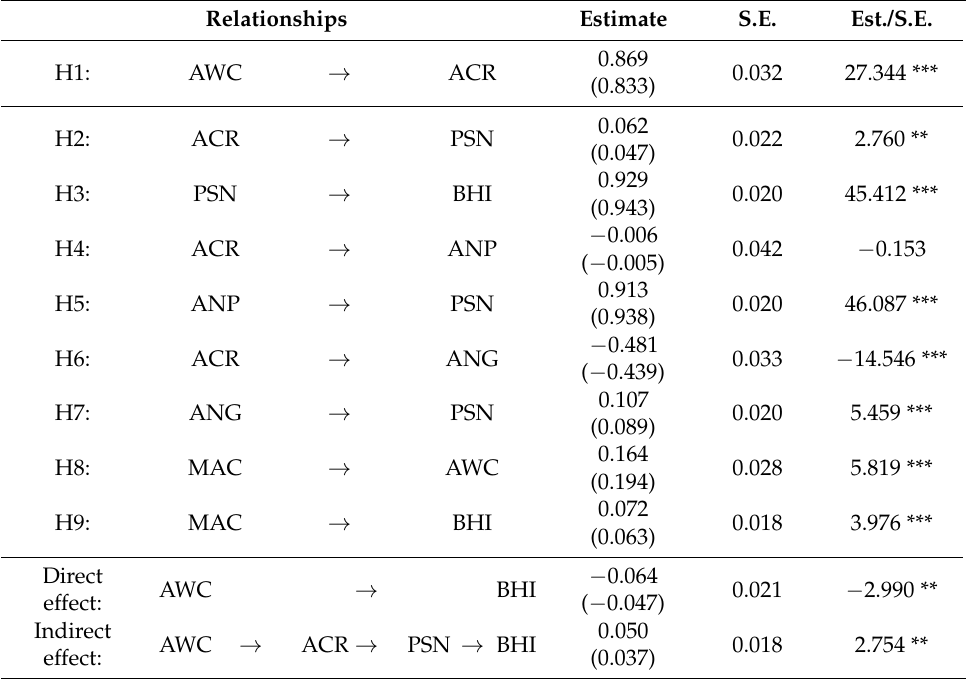
Table 5. The results of fully latent structural regression model ( n = 1221). Relationships Estimate S.E. Est./S.E.